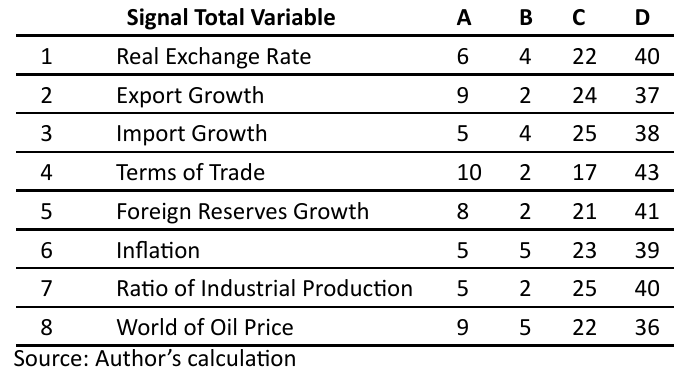
Table 4: Signal Total in Indonesia